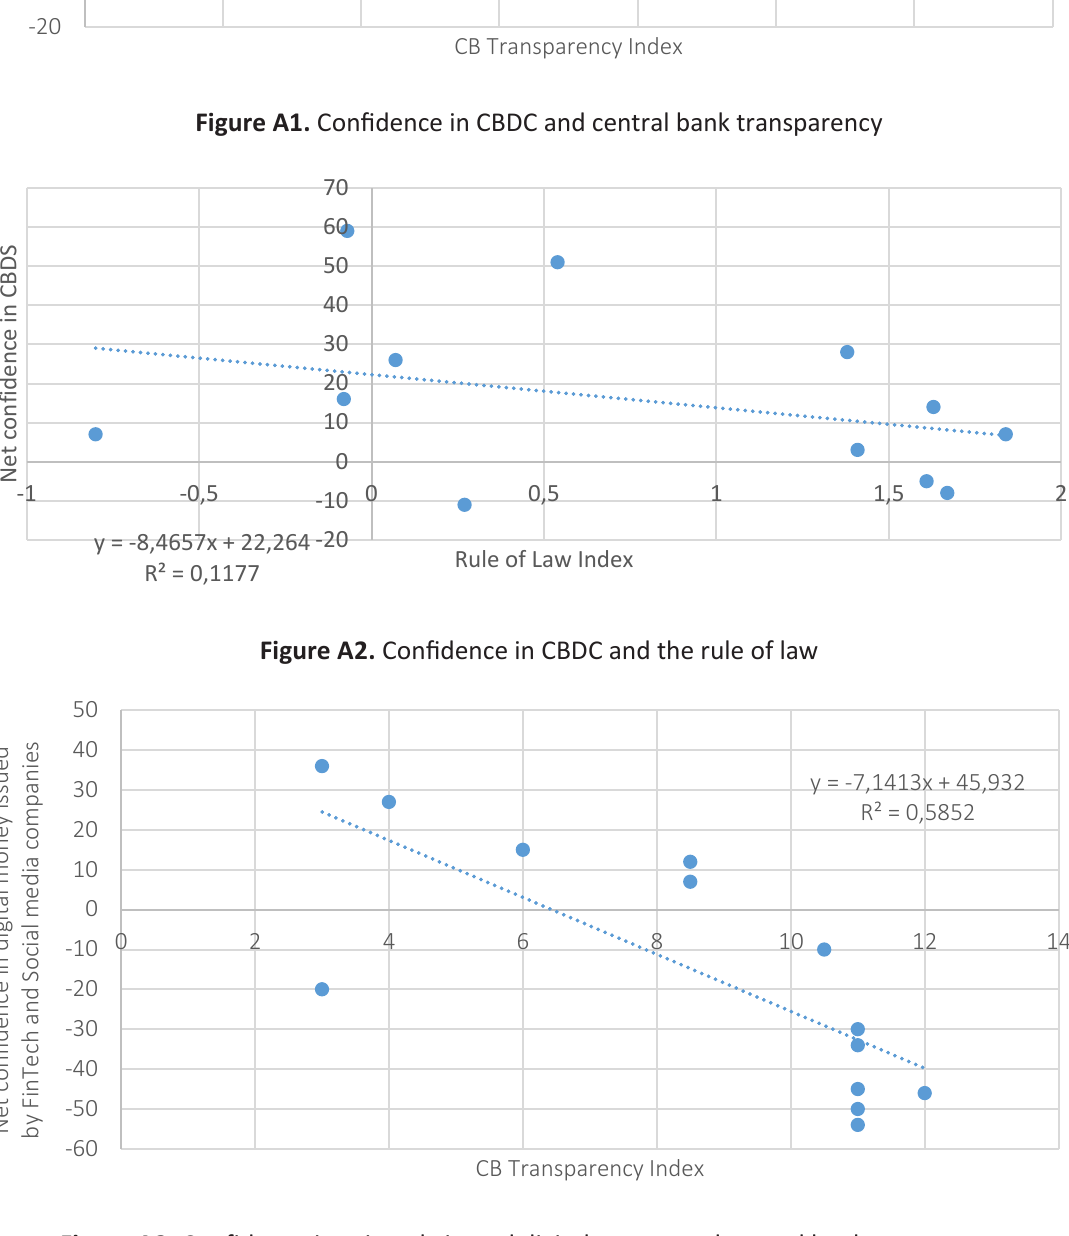
Figure А3. Confidence in privately issued digital money and central bank